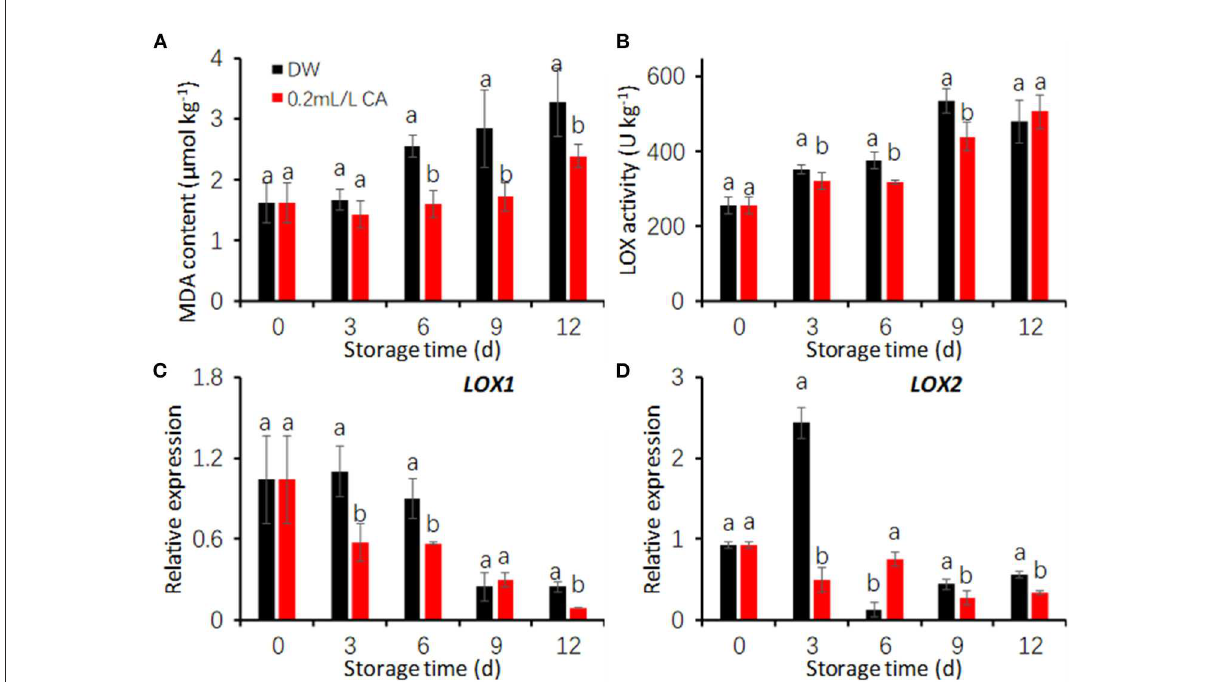
FIGURE5 Effects of citronellal (CA) treatment on malondialdehyde (MDA) content (A) and LOX activity (B) and gene expression (C,D) in fresh-cut taros. DW, distilled water. The expression levels were all normalized to 100% (1.0) at 0 d (before treatment). Each value is presented as the mean ± SE ( n = 3). Statistical differences ( p ≤ 0.05) are indicated as different letters above the